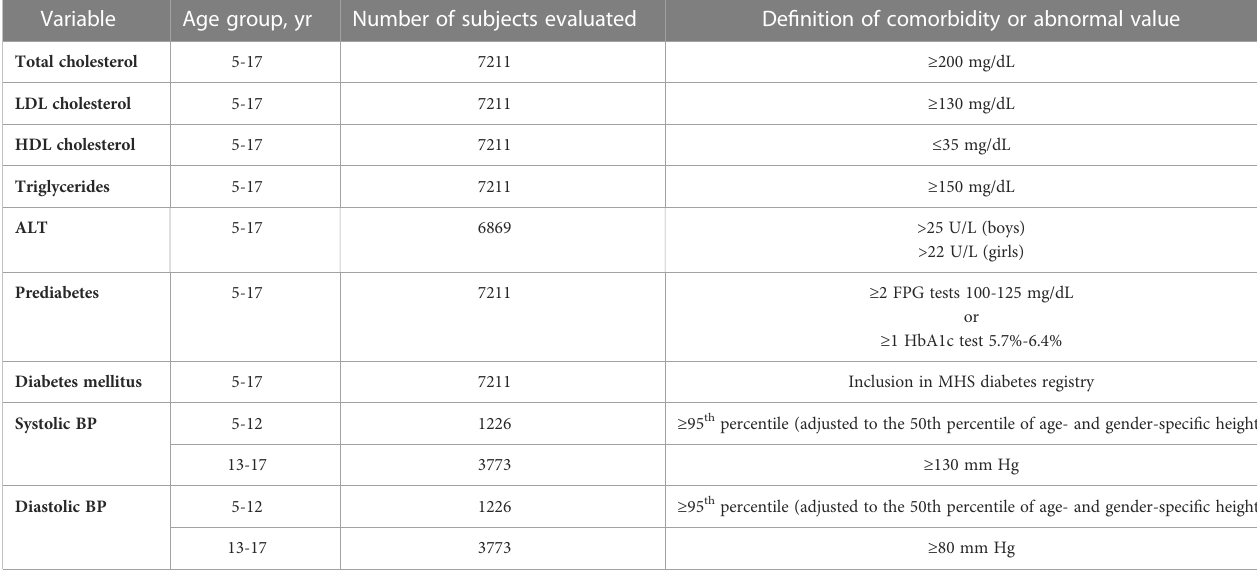
TABLE 1 De fi nitions of comorbidities and abnormal values for cardiometabolic variables. Variable Age group,